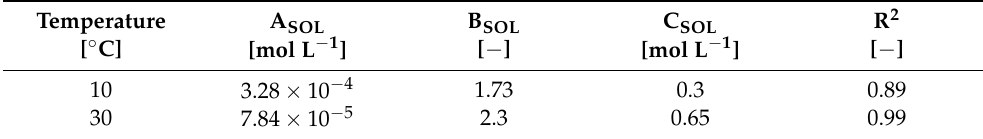
Table 4. Parameters of the solubility curve for succinic acid in aqueous Na 2 SO 4 solution fitted to Equation (12). Temperature